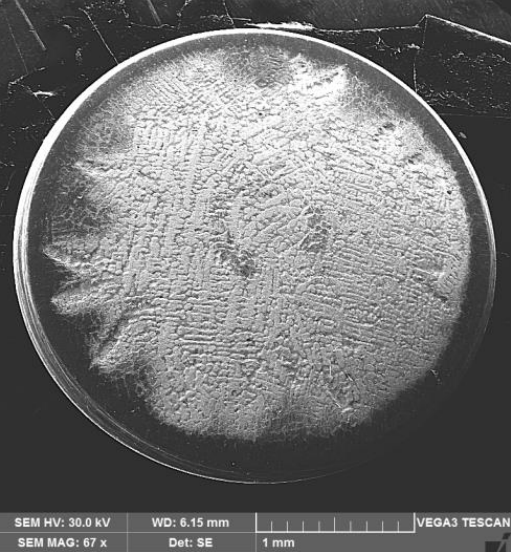
Figure 11. SEM macrograph of the unmelted surface tested by cavitation after 165 min.